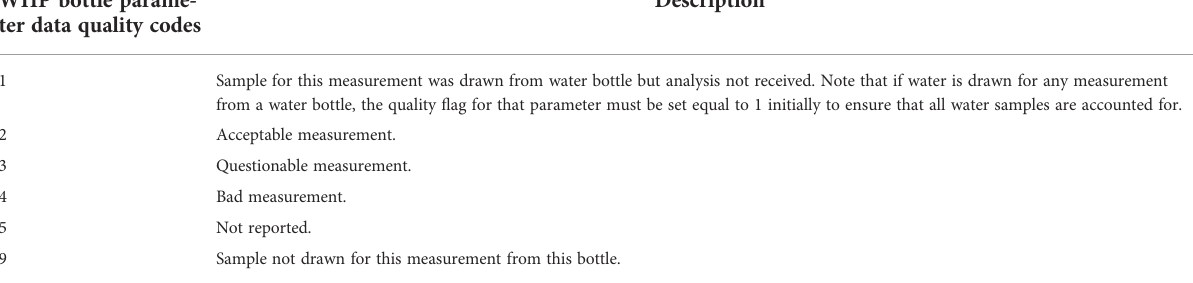
Woce Hydrographic Program (WHP) bottle parameter data quality codes (https://www.nodc.noaa.gov/woce/woce_v3/wocedata_1/ whp/exchange/exchange_format_desc.htm). WHP bottle